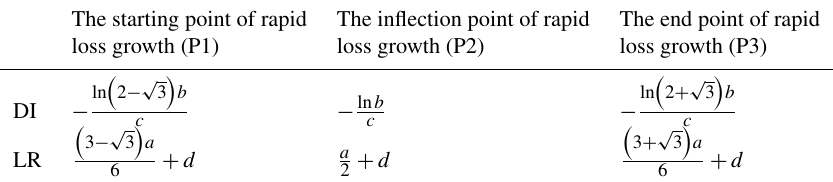
Table 2. Key point coordinates of the vulnerability curve. The starting point of rapid The inflection point of rapid The end point of